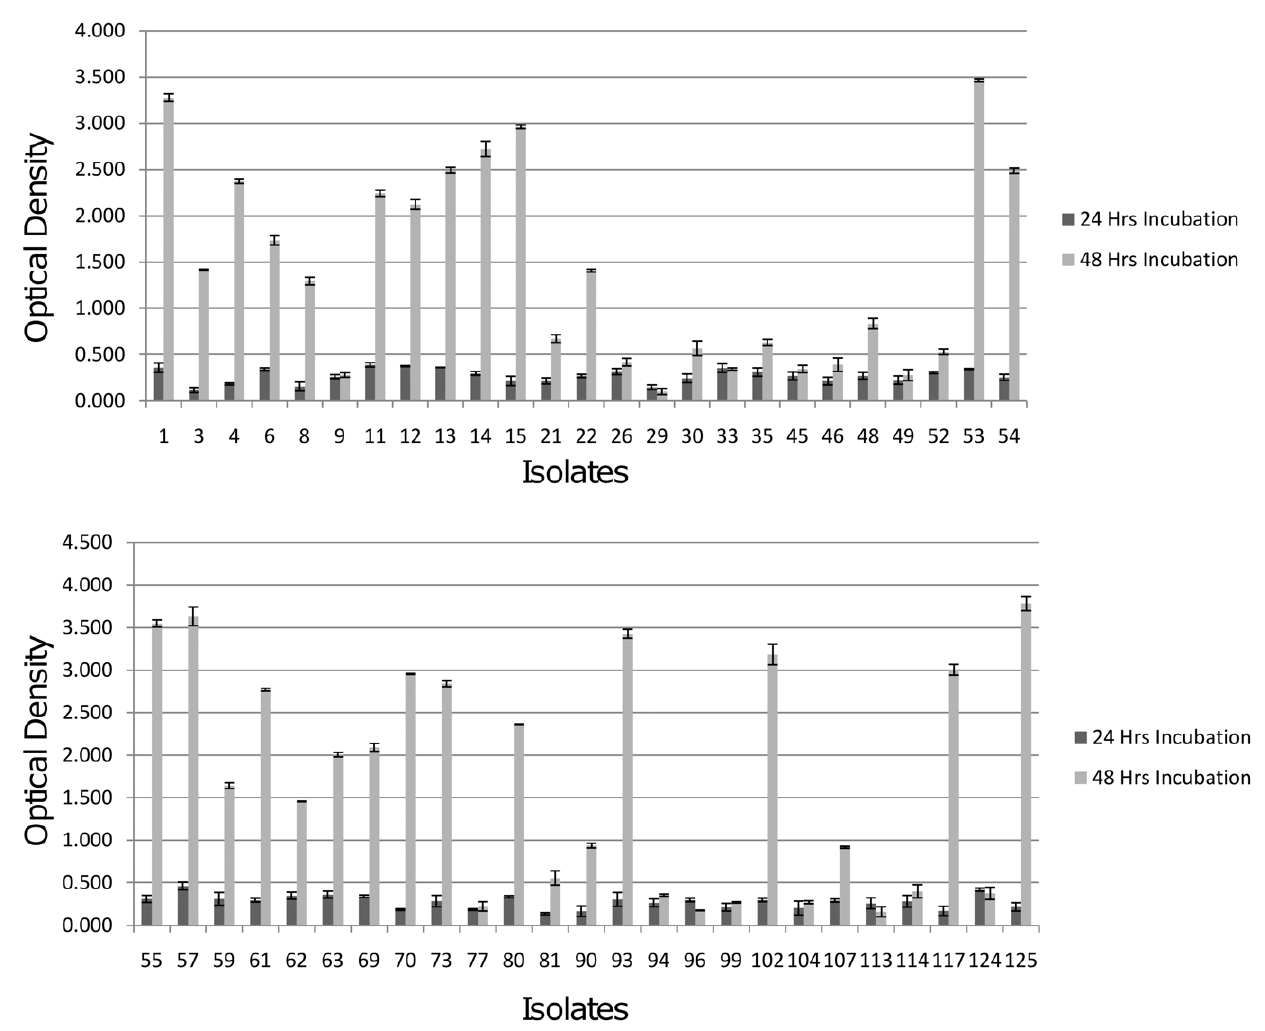
Figure 1. Biofilm formation among the 50 isolates of Acinetobacter spp. in microtiter plates. Strain numbers are designated in x axis. About 60% of the isolates significantly forms biofilms when incubated for prolonged hours. Data are pooled from triplicate experiments. The results are expressed as the mean and the error bars indicate the standard deviation. The P value was less than 0.05 ( P , 0.05).